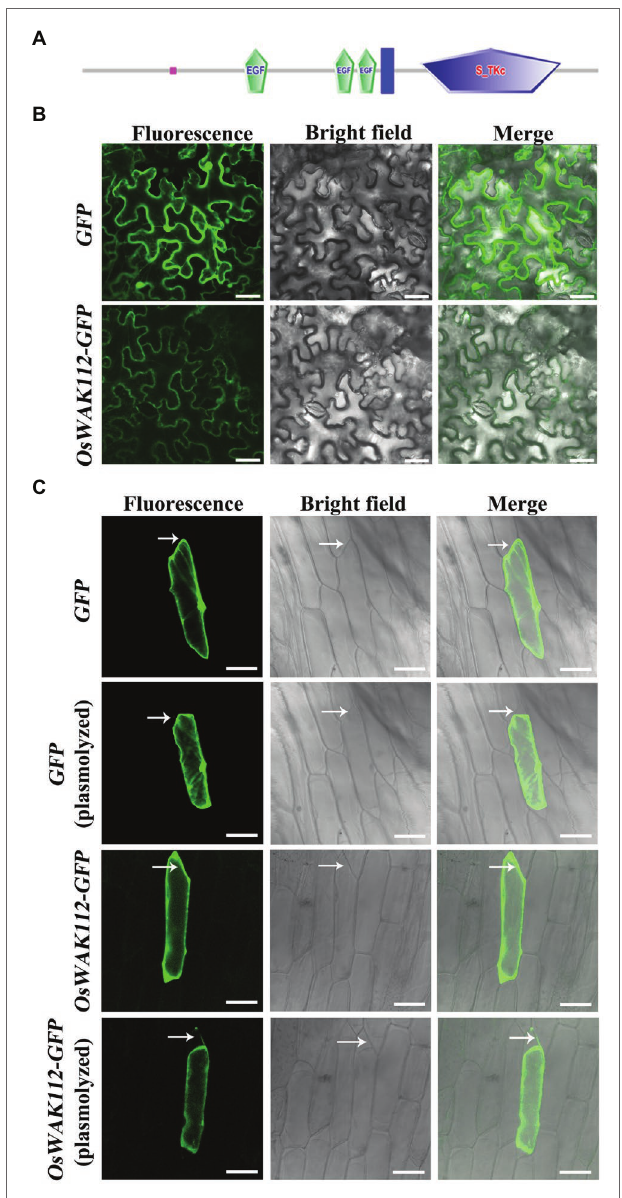
FIGURE 3 | The subcellular localization of OsWAK112 . (A) The protein structure of OsWAK112 as predicted by SMART. Pink box: low complexity region. EGF: epidermal growth factor-like domain. Blue box: transmembrane region. S-TKc: serine/threonine protein kinase, catalytic domain. (B,C) Subcellular localization of OsWAK112-GFP in tobacco and onion epidermal cells. Arrows in (C) indicate the cell wall region where plasmolysis happened. Scale bar = 50 μ m in (B) and 100 μ m in (C)